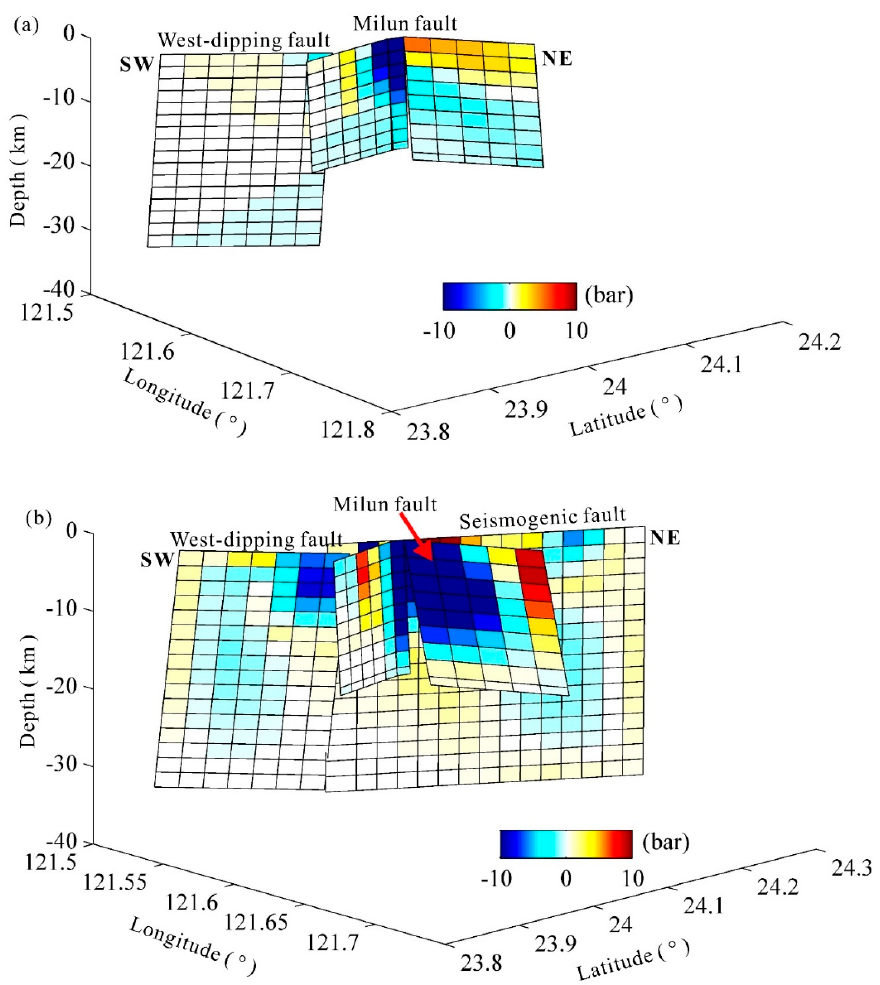
Figure 7. The Coulomb failure stress change on the faults. ( a ) The CFS change on the two triggered faults including the Milun and west-dipping faults calculated by the co-seismic faulting model of the seismogenic fault (Figure 4a). ( b ) The CFS change on all the faults calculated by the co-seismic faulting models shown in Figure 4a.